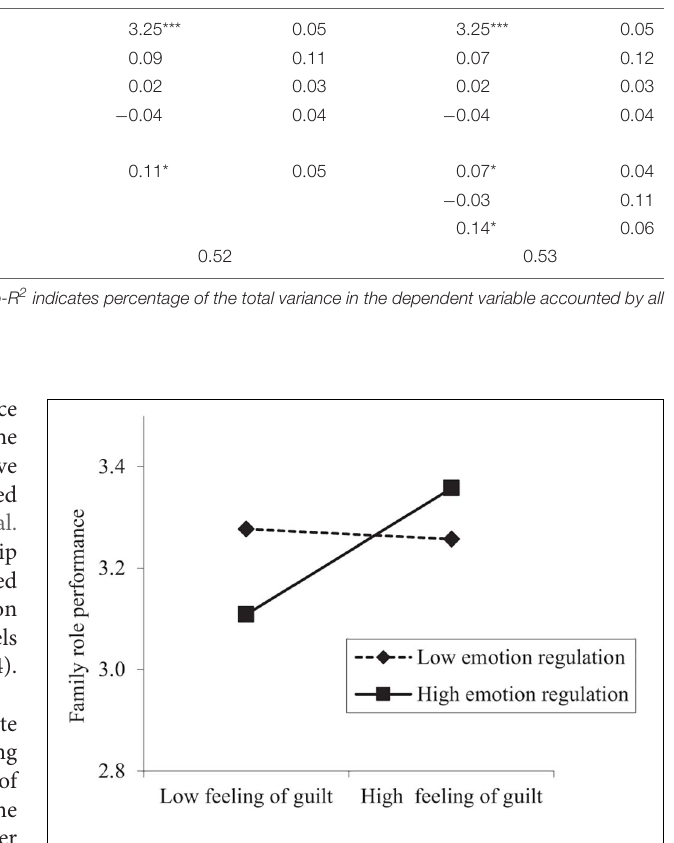
FIGURE 2 | Moderation effect of emotion regulation on the relationship between daily feeling of guilt and family role